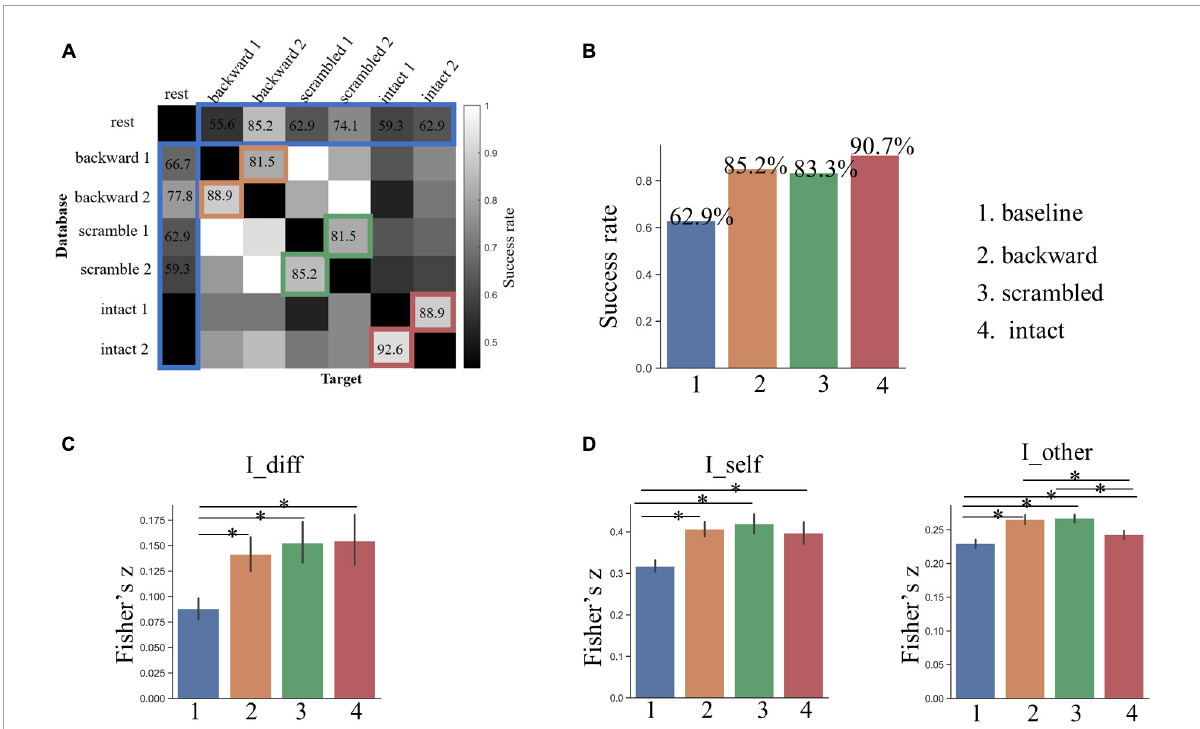
FIGURE3 (A) The result of individual identification along the language hierarchy based on whole-brain FCs. (B) The success rate of identification across all possible pairs of sessions. Grids marked by colors are the interests of this study. The bar plot shows the group-level success rates averaged across corresponding pairs for the four conditions. (C) Individual identifiability quantified by I_diff. (D) Within- and between-subject similarity across sessions quantified by I_self and I_other, respectively. The asterisk indicates a significant difference between two conditions at p < 0.05 after FDR correction. The error bars denote the standard deviation of